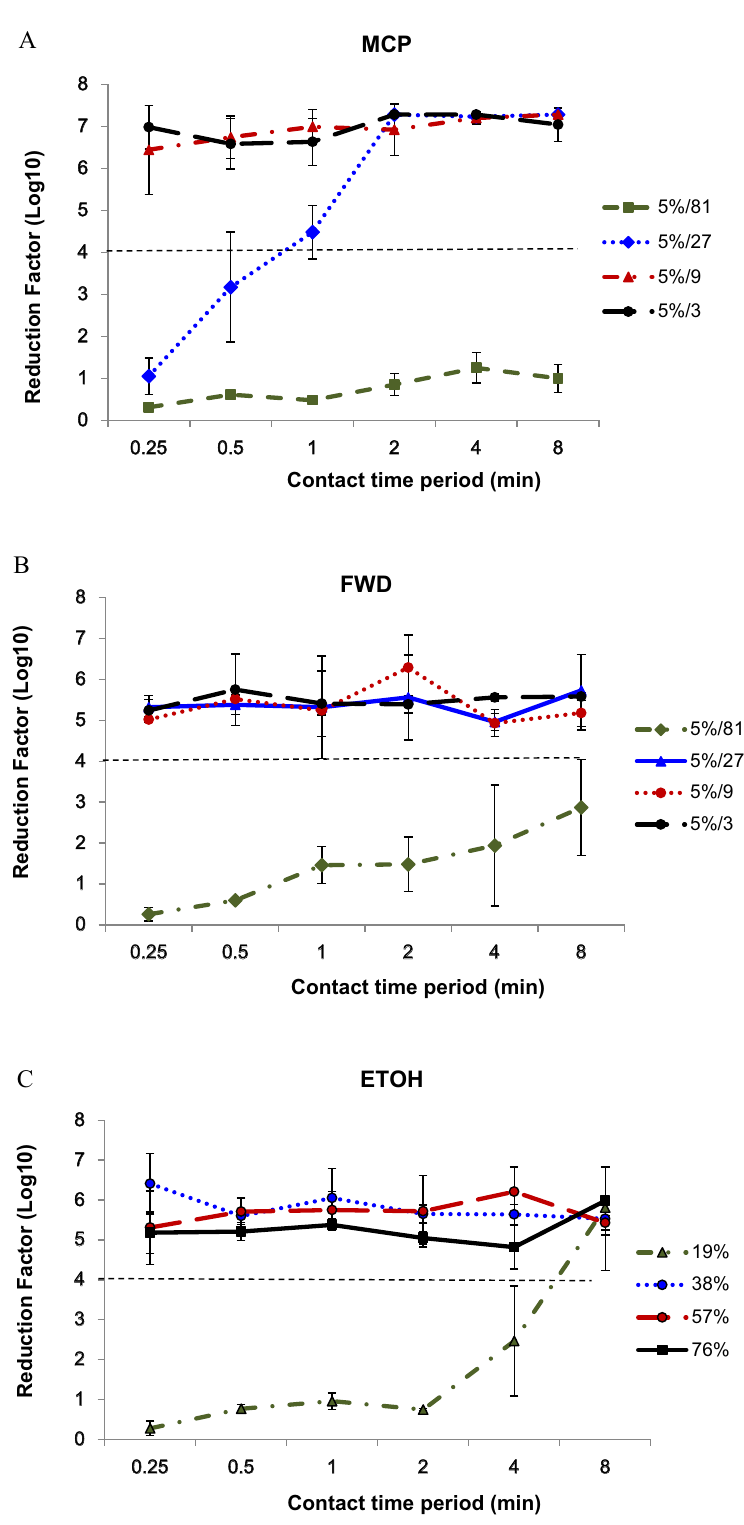
Figure 1. Virucidal activity of MCP ( A ), FWD ( B ) and ethanol ( C ) against Nipah virus. The biocide concentrations ranged from ~ 1.6% to 0.06% (5%/3 to 5%/81, using a three-fold serial dilution scheme for MCP and FWD) or 19% to 76% for ethanol with contact times of 15 s to 8 min. The virucidal efficacy of the three disinfectants against Nipah virus was evaluated by quantitative suspension assay and residual infectivity was determined by virus titer using one-step real-time